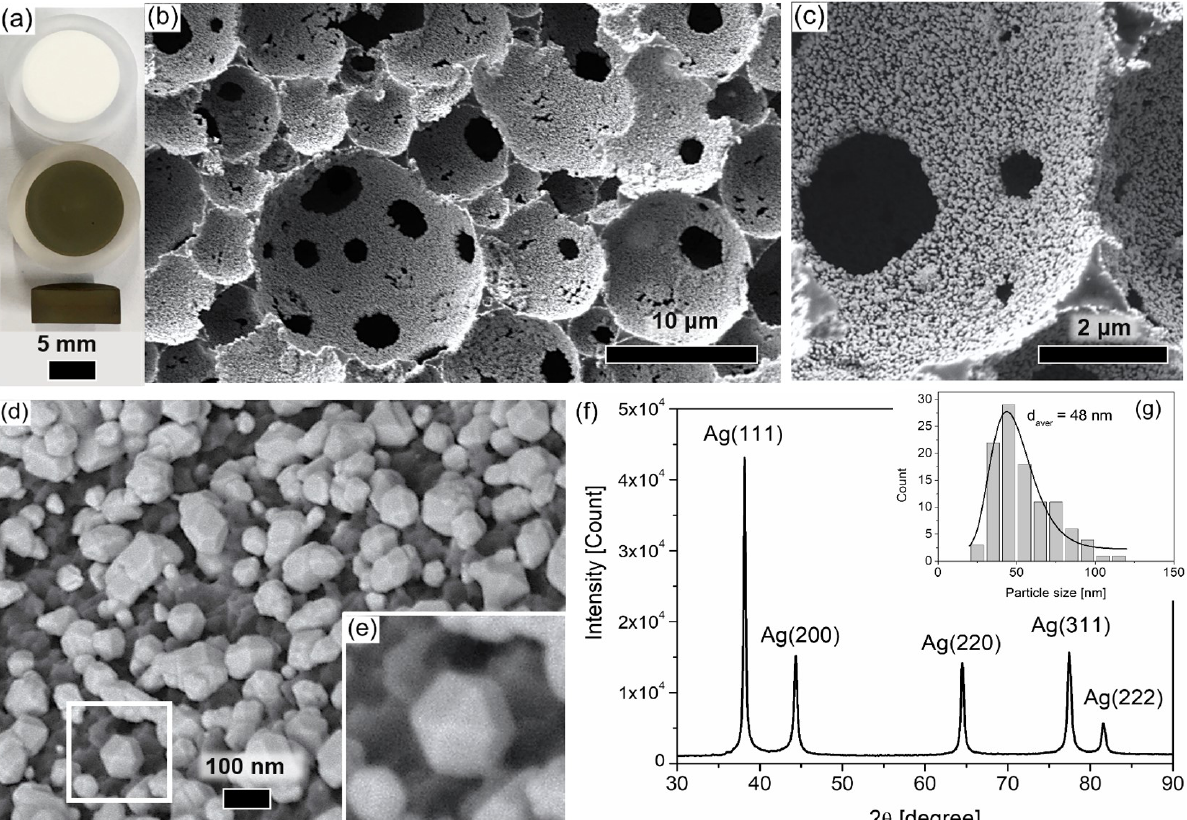
Figure 5. ( a ) Photograph of prepared polyHIPE with AgNPs. ( b – d ) SEM images showing AgNP crystals grown from the polyHIPE pore surface at four magnifications. A cuboctahedron-shaped AgNP is magnified ( e ) showing its attachment to polymer ridges on the pore surface. XRD pattern of the AgNP crystals. ( f ) shows high crystallinity of the composite polyHIPE and all characteristic refraction peaks for silver. ( g ) AgNP particle size distribution with calculated average diameter from the fitted log-normal distribution curve. The sample was prepared with 4 mM H 2 SO 4 (see Section 2.6). The reaction time was 1